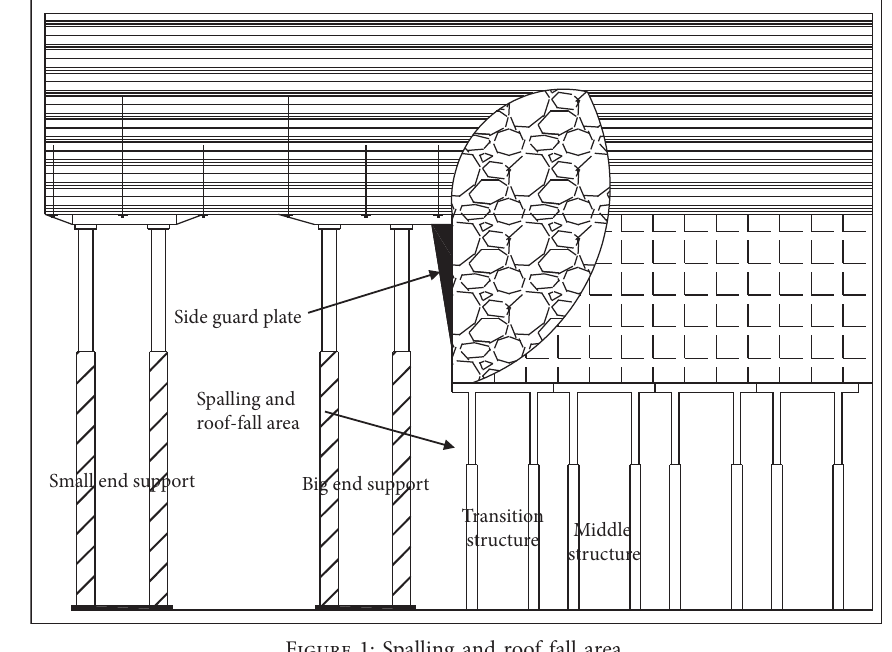
Figure 1: Spalling and roof fall area.